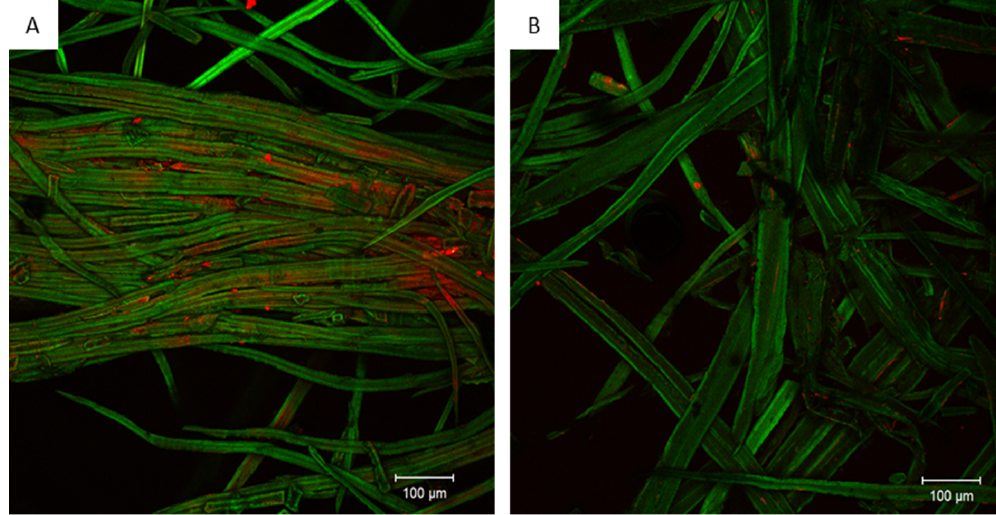
Figure 8. CLSM image showing the location of the resin (red) on wood fiber (green) before ( A ) and after ( B ) decontamination treatment, non-published data.